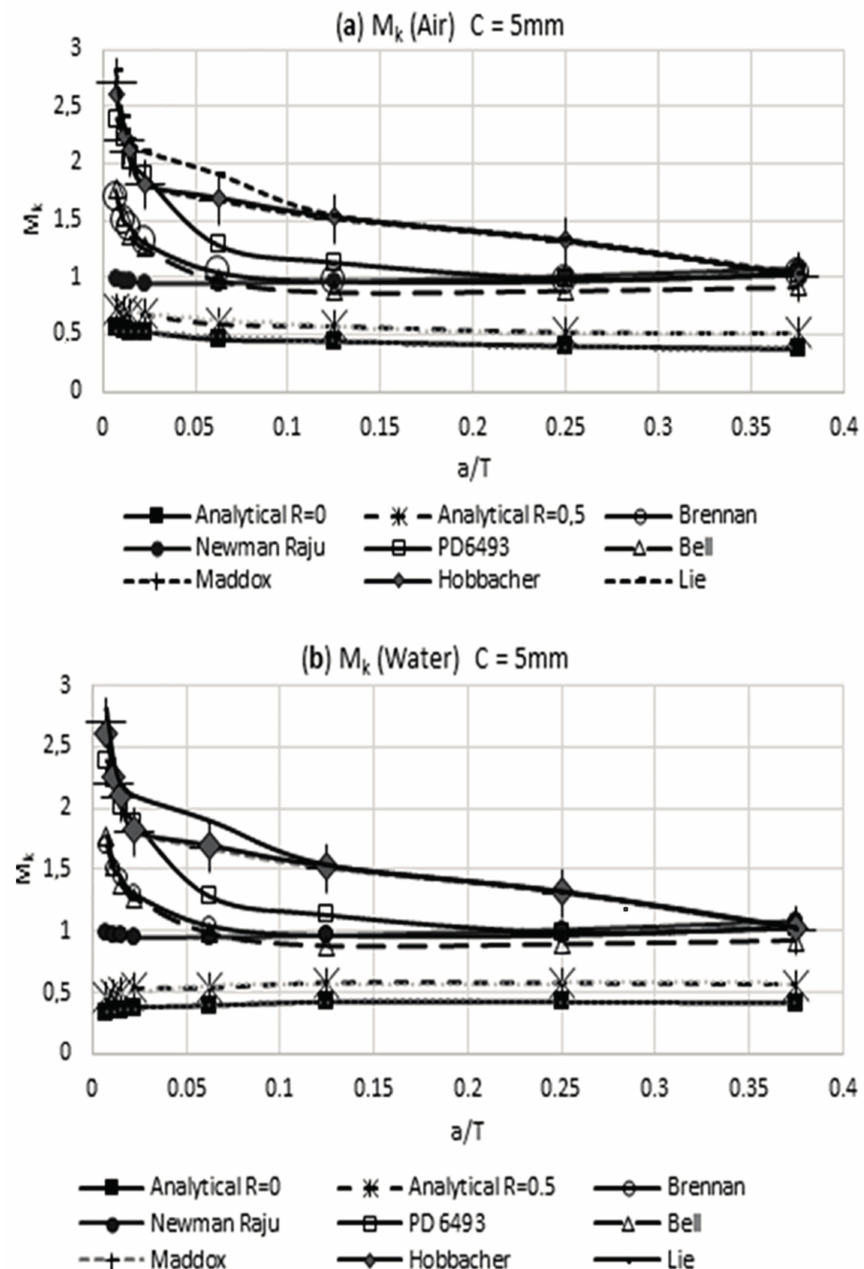
Figure 11. Modified weld magnification factor M k with the presence of residual stress vs other researchers: ( a ) air and weld size of 5 mm and ( b ) water and weld size of 5 mm. With the results that were obtained for the weld magnification factor, a regression analysis is carried out to obtain analytical equations that relate to the dimensionless size of the crack. Table 7 shows the expressions of M k(a/T) for the free condition of residual stresses. In Table 8, the expressions of M k(a/T ) are shown for the condition of post-weld cooling in calm air. Finally, Table 9 shows the expressions of M k(a/T) for the condition of post-weld cooling in water (in the equations Ω = a/T). These analytical expressions are particularly useful to establish models for the prediction of fatigue crack propagation and the design of a life management program for welded structures of the studied